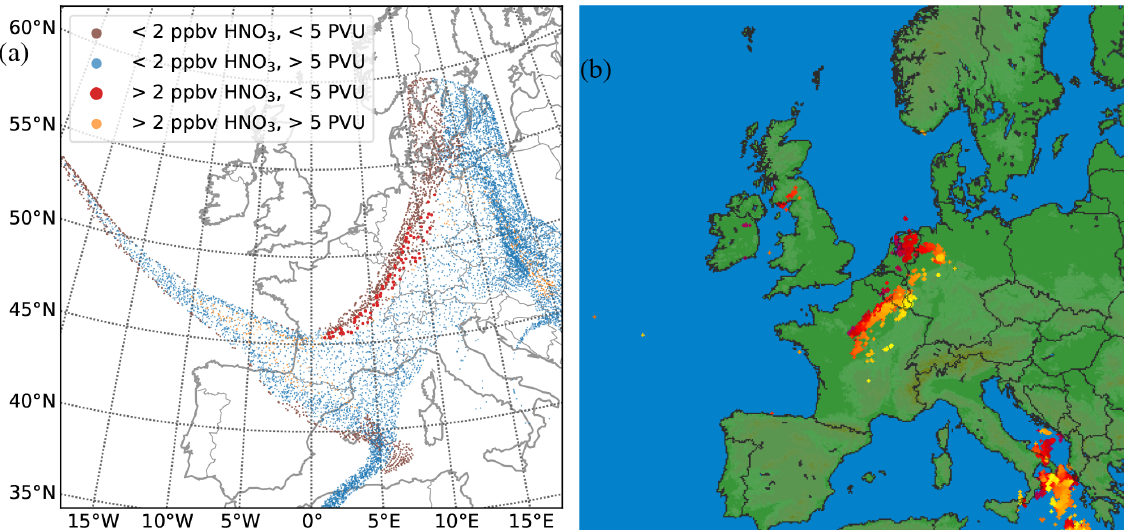
Figure 12. Panel (a) shows the positions of air parcels observed as part of the 7 October 3-D retrieval on 29 September 18:00UTC (8d before measurement). Air parcel colouring: brown – less than 2ppbv HNO 3 , less than 5PVU; light blue – less than 2ppbv HNO 3 , more than 5PVU; red (larger markers) – more than 2ppbv HNO 3 , less than 5PVU; orange – more than 2ppbv HNO 3 , more than 5PVU. HNO 3 VMRs considered are from the 7 October 3-D retrieval. Panel (b) shows lightning strikes between 29 September 18:00UTC and 30 September 00:00UTC in the area, based on very-low-frequency (VLF) radio observations. Lightning strikes are indicated by purple-to-yellow colour scale, depending on their time of occurrence within the given